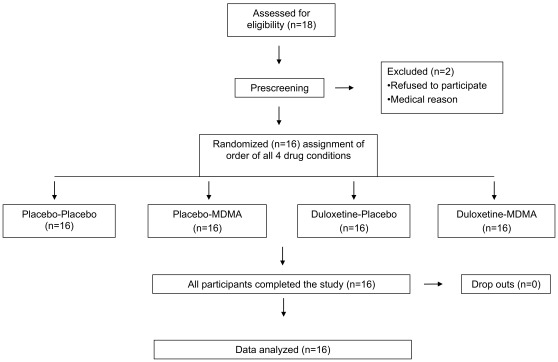
CONSORT flowchart.